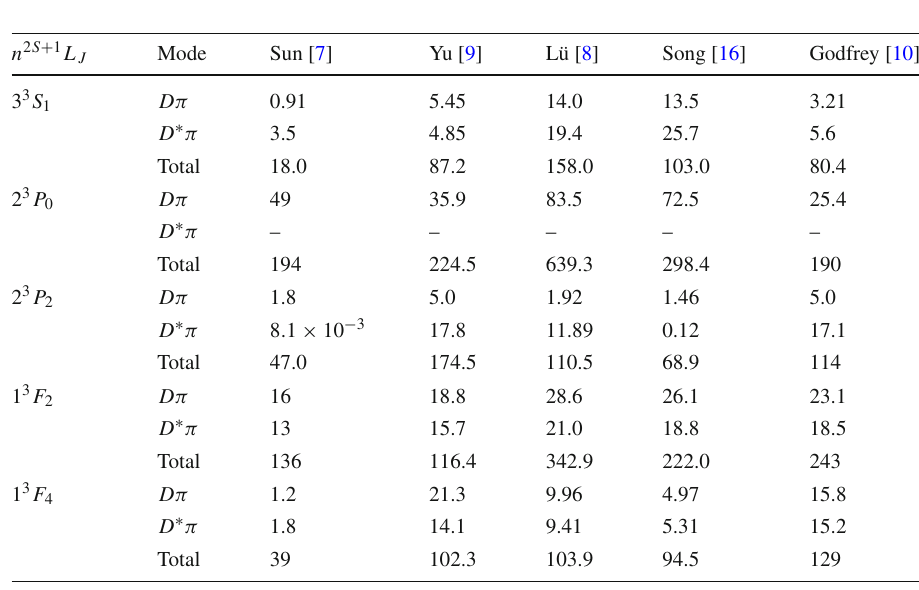
Table 2 Decay widths of ( 3000 ) 0 with different D ∗ J assignments (MeV)